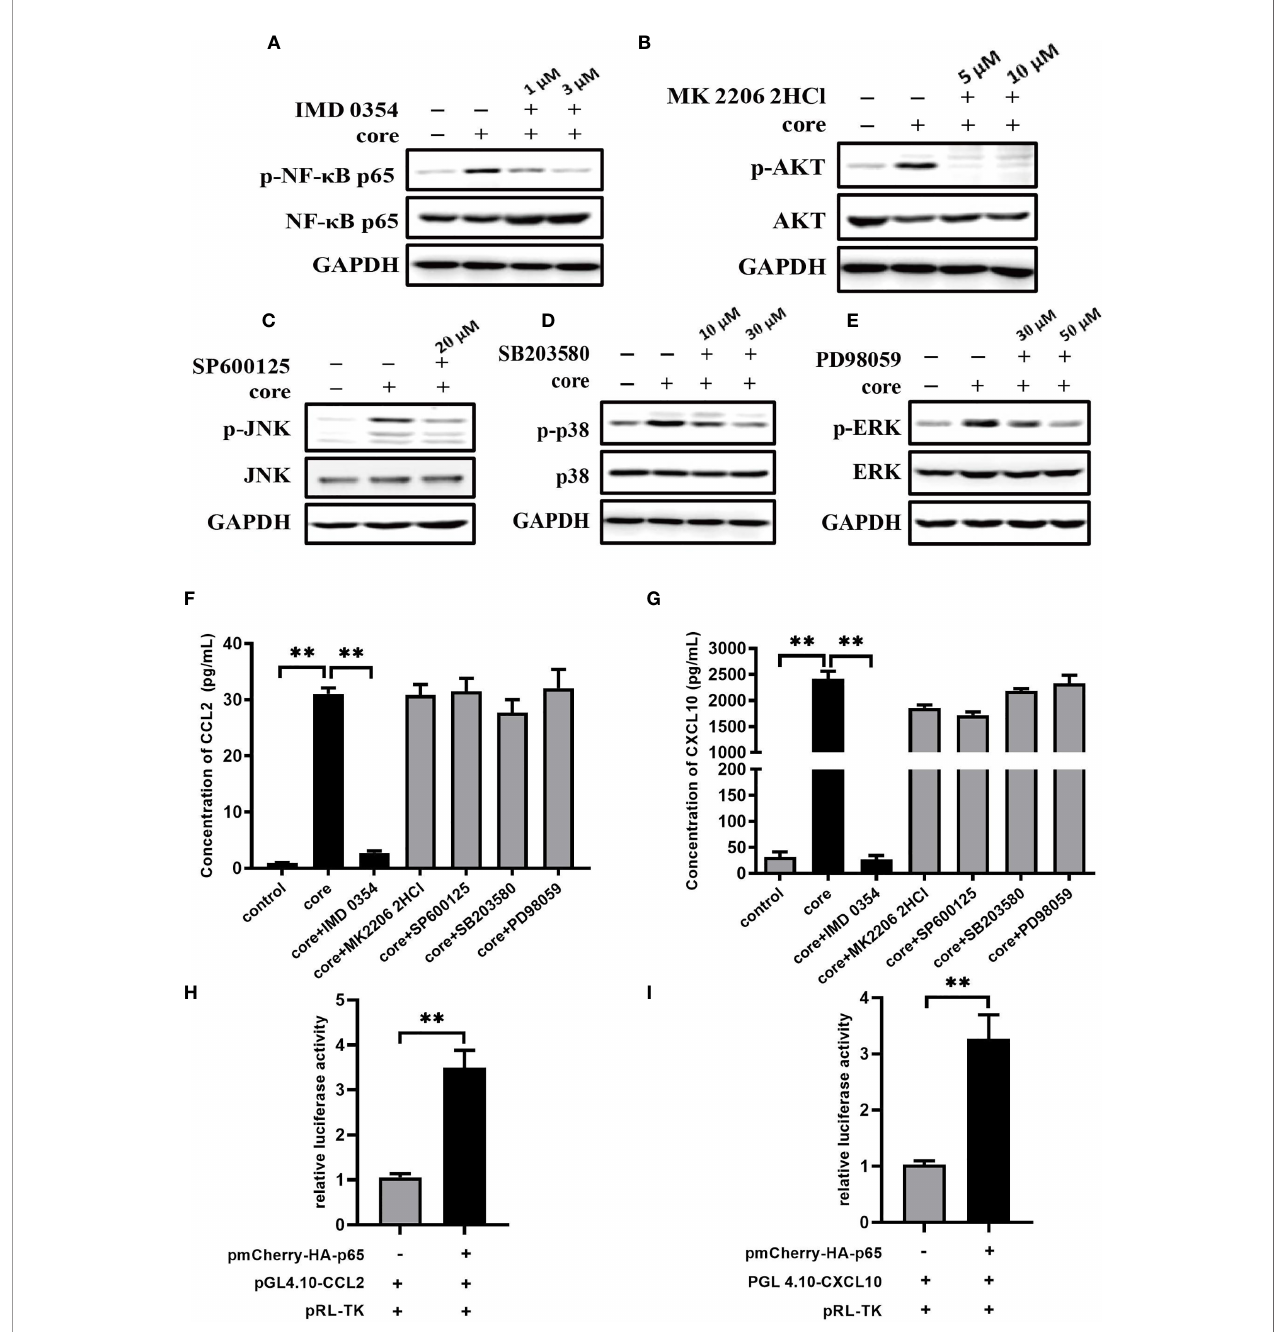
FIGURE 4 | NF- k B signaling pathway plays pivotal role in CCL2 and CXCL10 expression in macrophages induced by HCV core protein. (A – E) M F -THP-1 were pretreated with speci fi c inhibitor in different doses for 30 min and then treated with HCV core protein for 30 min. Cells were lysed and analyzed by immunoblotting with anti-p-NF- k B p65, anti-NF- k B p65, anti-p-AKT, anti-AKT, anti-p-JNK, anti-JNK, anti-p-p38, anti-p38, anti-p-ERK, anti-ERK and anti-GAPDH antibodies to determine the optimum concentration of inhibitors: IKK b inhibitor IMD 0354 was 3 m M, Akt inhibitor MK 2206 2HCl was 5 m M, JNK inhibitor SP600125 was 20 m M,